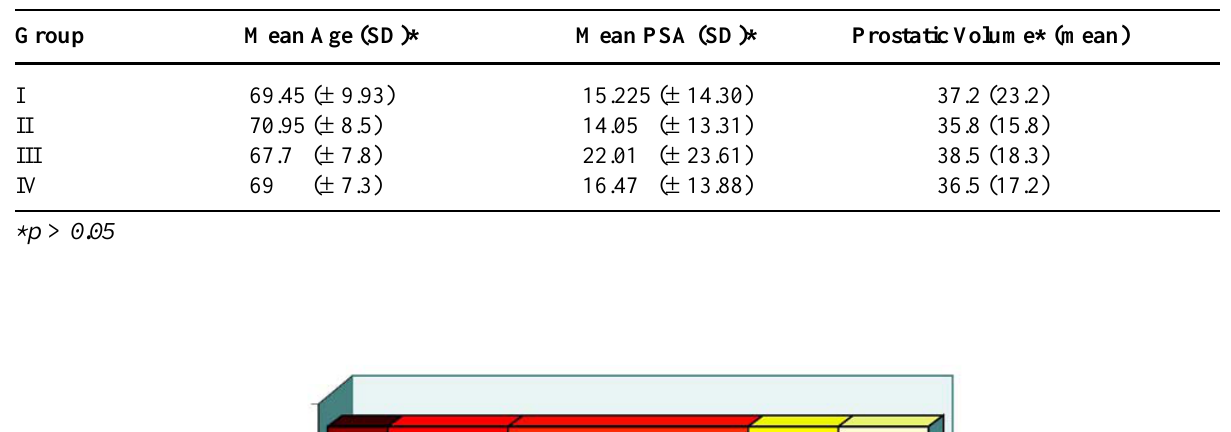
Table 1 – Distribution of patients according to age, PSA values, and prostatic volume in the 4 groups studied, confirming homogeneity among the samples.